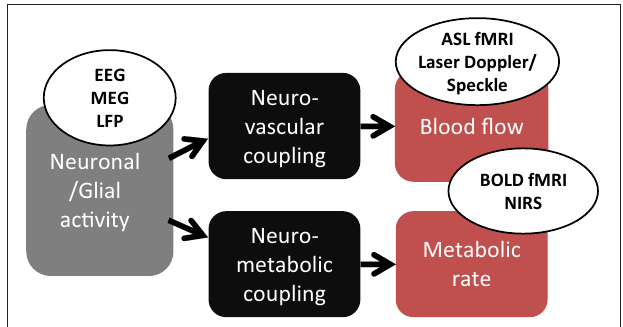
FIGURE 1 | Physiological mechanisms monitored in classical functional neuroimaging. Neuronal/glial activity provokes, by a neurovascular coupling, an increase of blood flow. In parallel, a neurometabolic coupling increase the oxygen consumption. EEG, electroencephalogram; MEG, magnetoencephalogram; LFP, local field potential (intracerebral electrode); ASL, arterial spin labeling; BOLD, blood-oxygen-level dependent; NIRS, near infrared